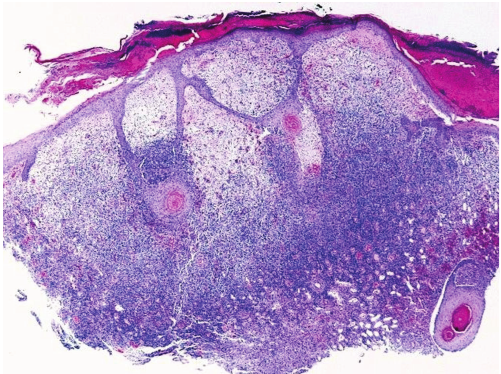
Figure 2: Microscopic appearance: raised papule with parakeratotic crust and acanthosis with thin epidermal strands extending deeply in the underlying dermis. The upper dermis is markedly edematous with marked capillary proliferation. The deeper dermal part of the lesion is composed of reactive lymphoid infiltrates. Figure 1: Clinical picture.